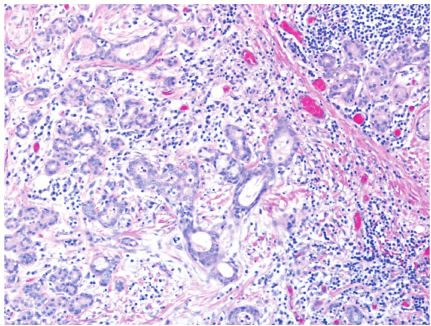
Figure 11: Sialadenitis: there is extensive lymphoid infiltrate with interstitial fibrosis and acinar atrophy (hematoxylin-eosin, original magnification ×